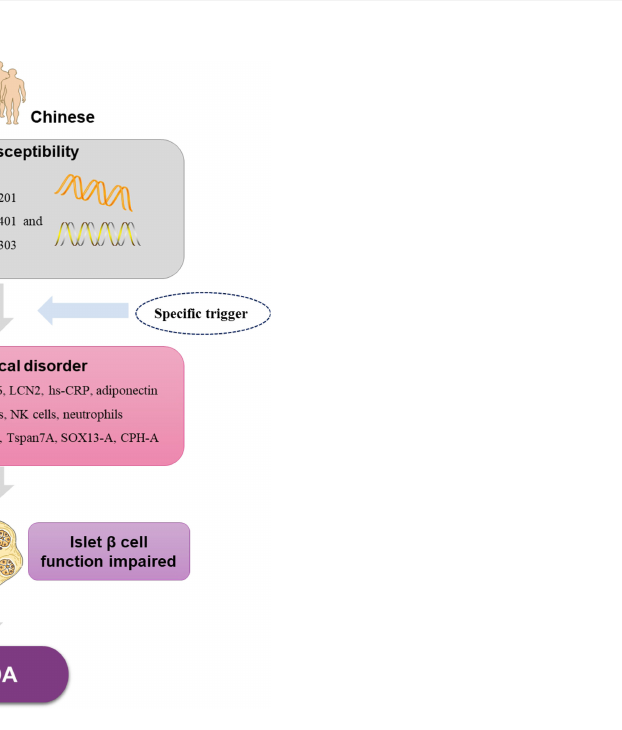
FIGURE 1 The immunological features and genetic characteristics of Chinese LADA base on current research. HLA, human leukocyte antigen genes; PTPN22, protein tyrosine phosphatase nonreceptor 22; IL-6, interleukin-6; LCN2, lipocalin 2; hs-CRP, high-sensitivity C-reactive protein; NK cells, natural killer cells; GADA, glutamic acid decarboxylase autoantibody; IA-2A, protein tyrosine phosphatase IA-2; ZnT8A, zinc transporter-8 antibodies; Tspan7A, transmembrane protein 7 autoantibodies; CPH-A, carboxypeptidase H autoantibodies; SOX13-A, Syr-Box transcription factor